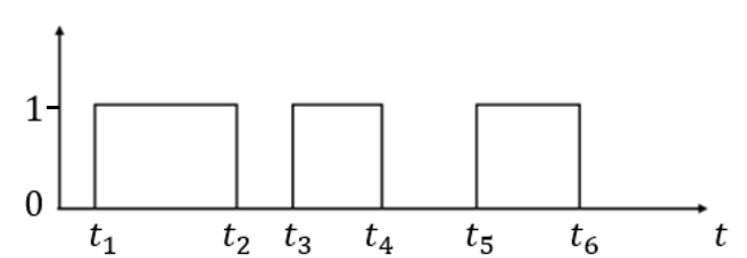
Figure 1. An example of one tapping rhythm data vector. The x -axis indicates the time and the y -axis indicates whether the screen is tapped (1 represents the screen being tapped, while 0 means that it is